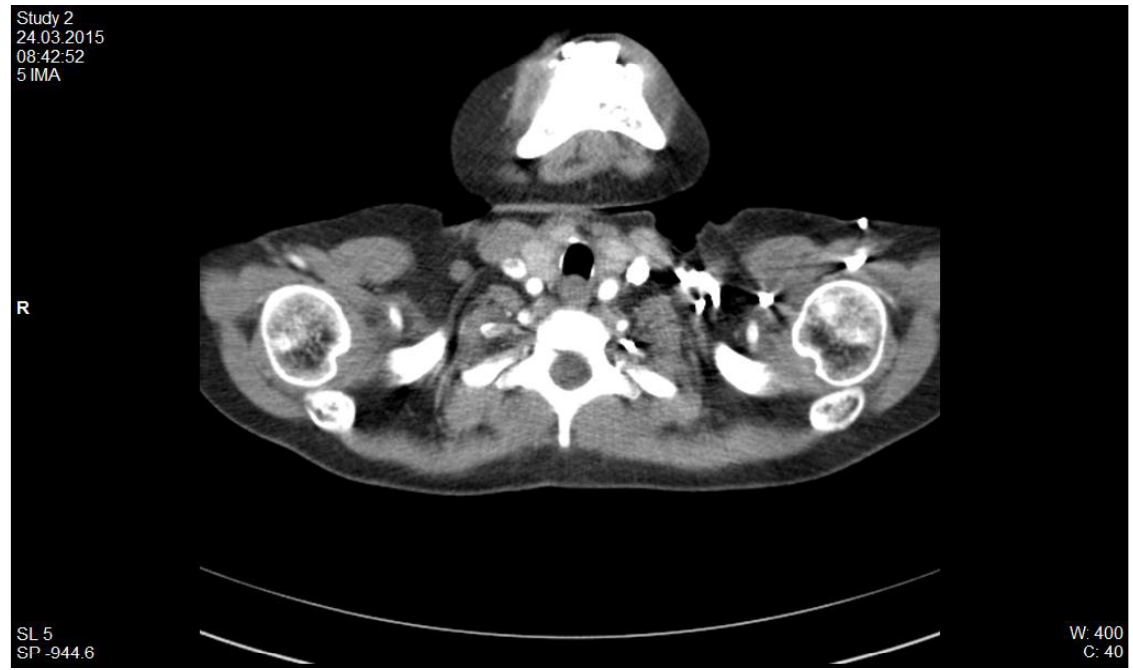
Figure 6. CT scan, right IJV thrombosis, calcifications in the trachea in the context of calciphylaxis.